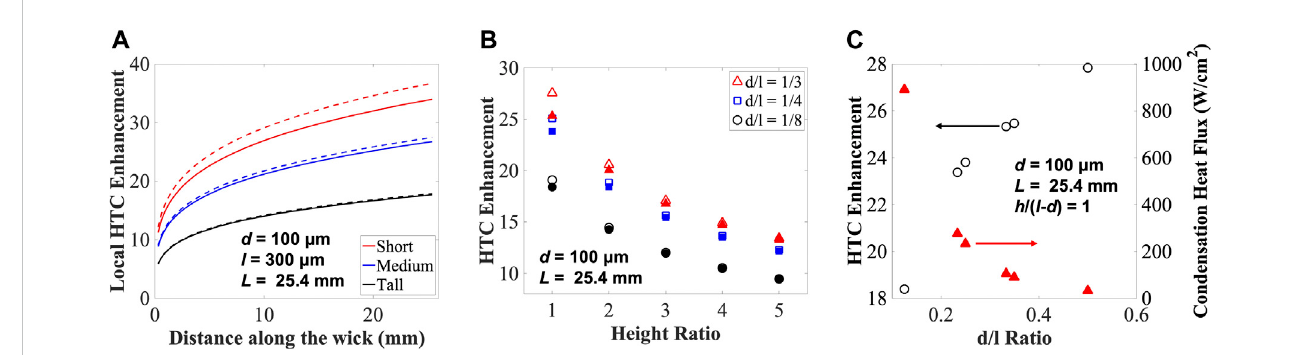
FIGURE 2 (A) Local HTC enhancement along the wick for geometries at different height ratios. Short, medium and tall pillars are de fi ned based on the pillar height ratio h /( l – d ) = 1, 2, and 5, respectively. Dashed lines represent the constant height discretized model, and solid lines represent the varying liquid height discretized model. (B) HTC enhancement for different d / l ratios at height ratios ranging from one to fi ve. Open symbols represent the constant height discretized model, and fi lled symbols represent the varying liquid height discretized model. (C) HTC enhancement and condensation heat fl ux as functions of d / l ratio at a constant height ratio. The geometry is d = 100 μ m and L = 25.4 mm. Water is the working fl uid.